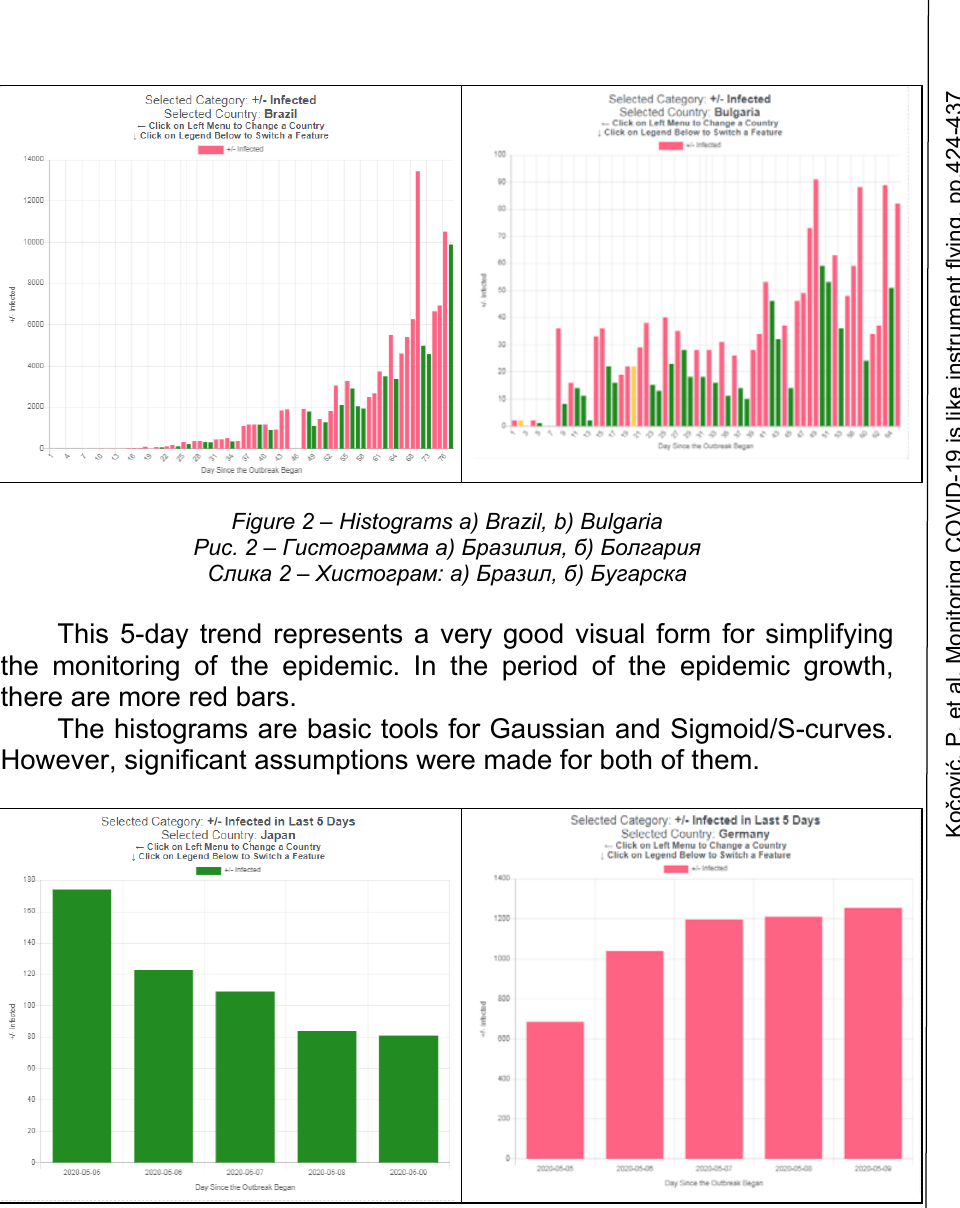
Рис . 3 – Пятидневный тренд – а ) положительный – Япония и б ) отрицательный